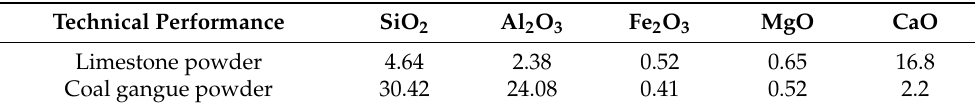
Figure 10. Optimum filler-asphalt ratio range of rubber asphalt mortar: ( a ) LPMRAM; ( b ) CGPMRAM. Table 3. The relative content of the main chemical components of limestone powder and coal gangue